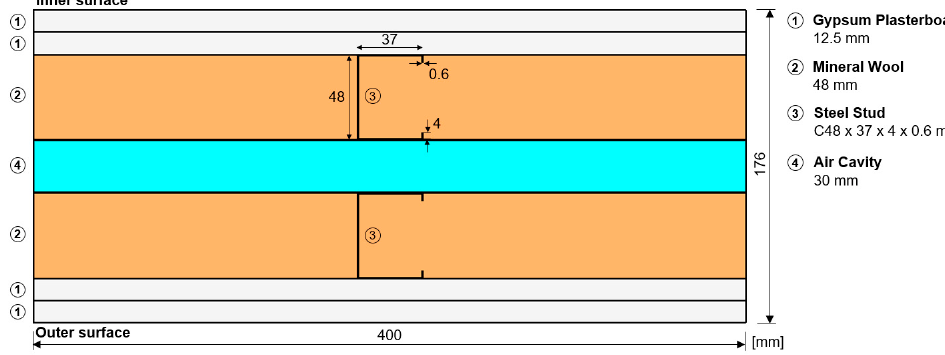
Table 1. Reference double-pane LSF wall materials, thickness (d), and thermal conductivities ( λ ). Material (Inner to Outer Layer)